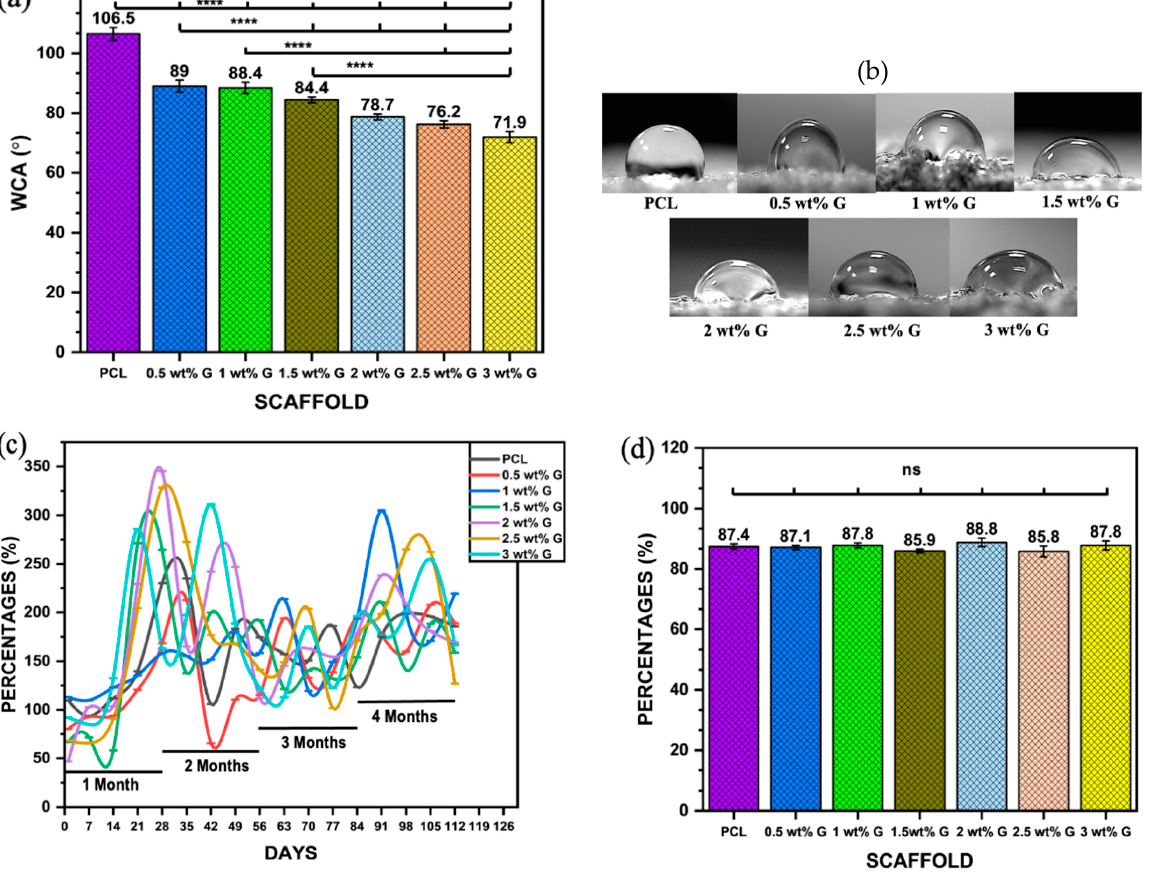
Figure 2. Physical properties: ( a ) water contact angle of PCL/G scaffold; n = 6; **** p < 0.0001. ( b ) Photograph of WCA of scaffold . ( c ) Water absorption rate of PCL/G scaffold; n = 3. ( d ) Porosity of PCL/G scaffold n = 9.